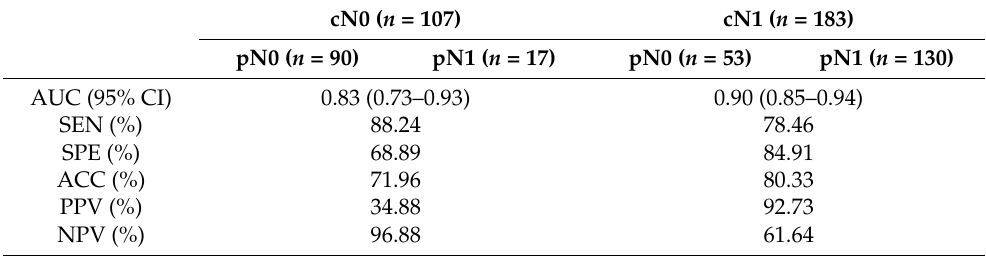
Table 4. Clinical validation of Combined Model for predicting ALN status in total